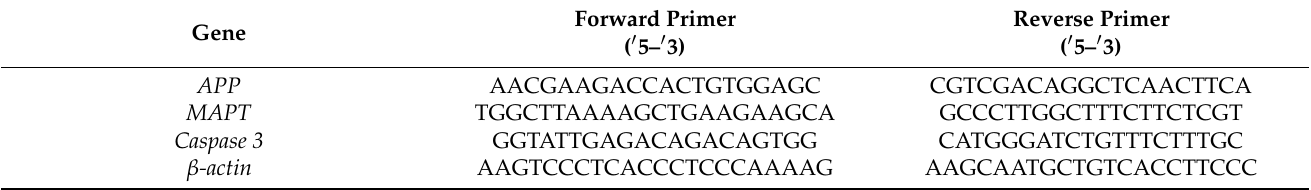
Table 2. Forward and reverse primers sequence used in